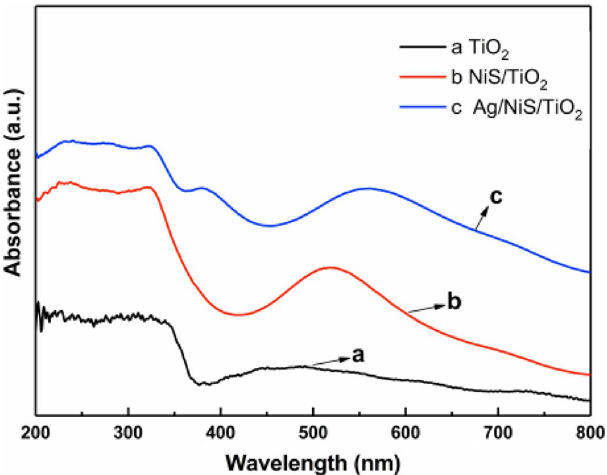
Figure 10. UV/Vis diffuse reflectance spectra of the prepared TiO 2 NWs, NiS/TiO 2 nanocomposite and Ag/ NiS/TiO